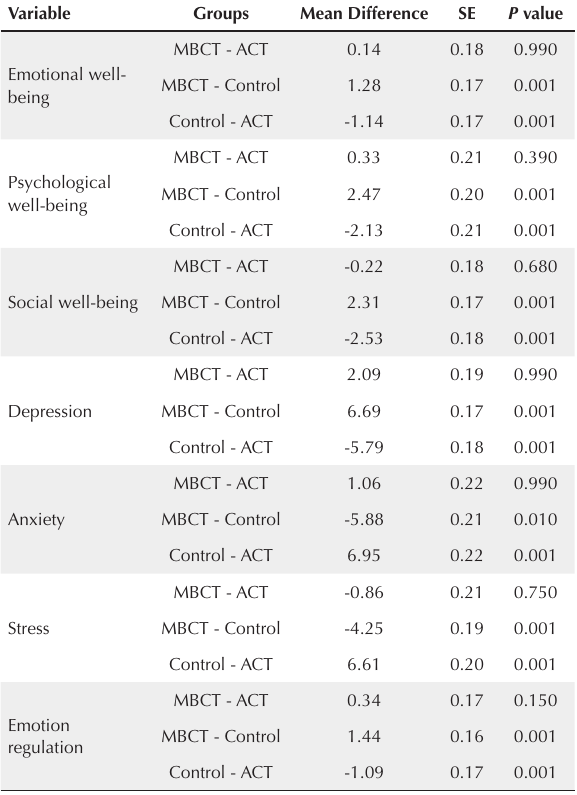
Table 4. Results of pairwise comparison of the variables across time series